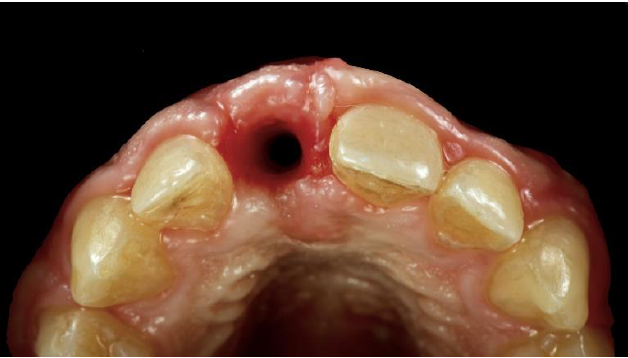
Figure 9. Intraoral view 3 months after second-stage surgery. Materials 2020 , 13 , x FOR PEER REVIEW